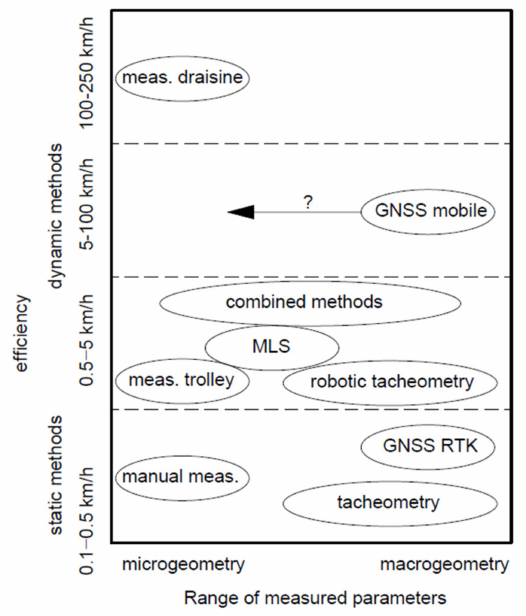
Figure 2. Comparing efficiency and usefulness of typical measurement methods. Own elaboration based on